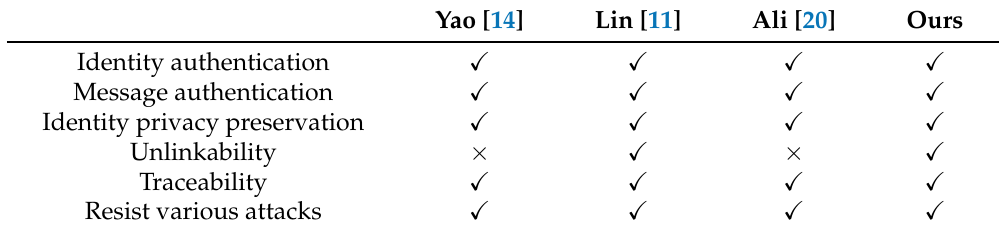
Table 3. Security